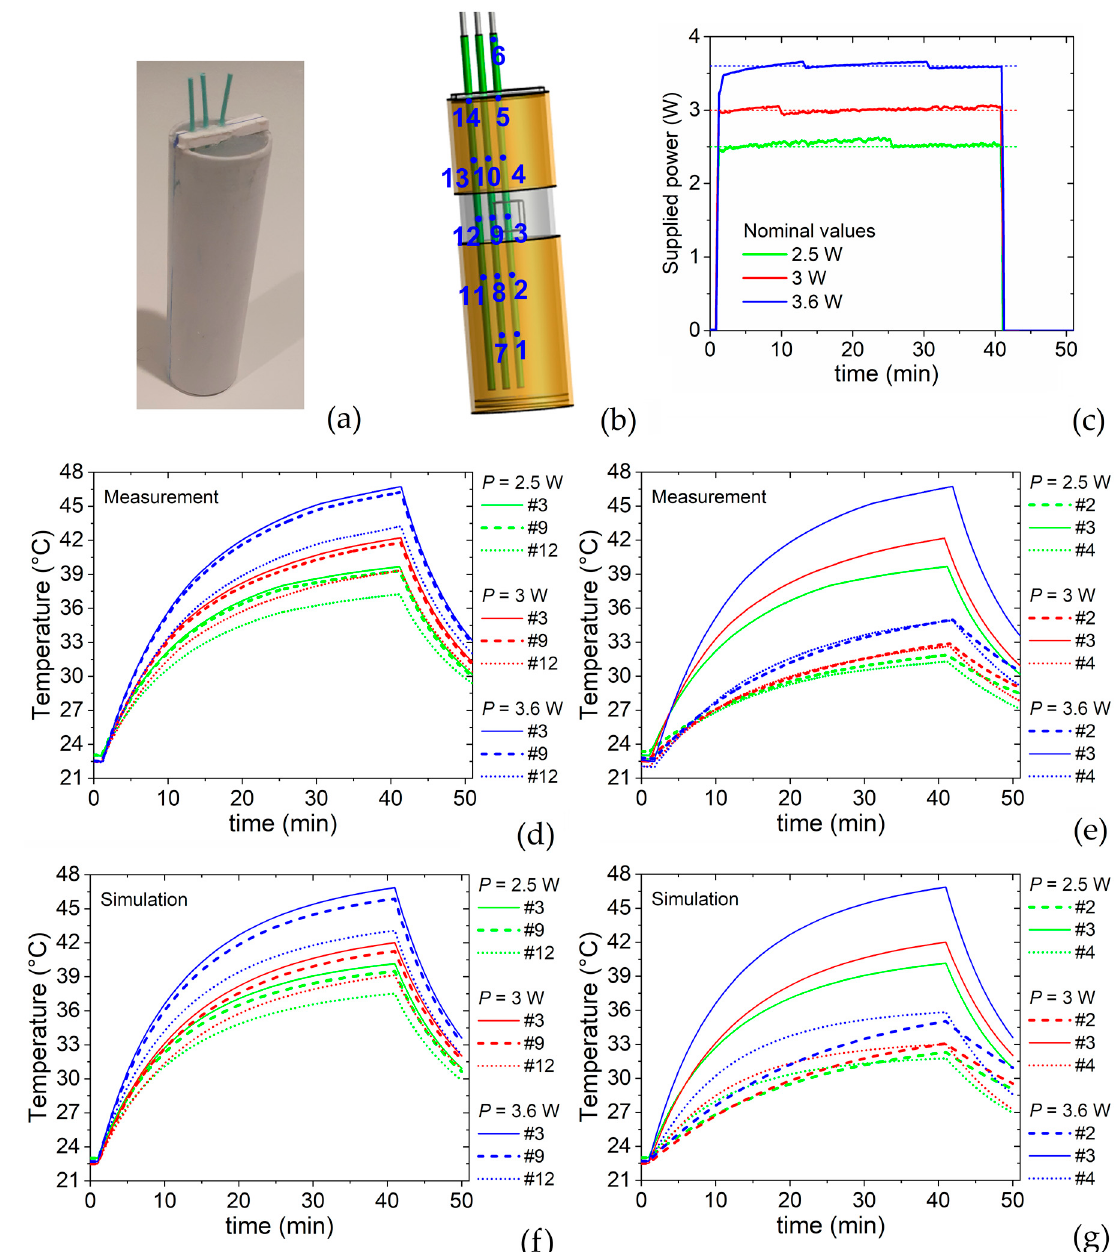
Figure 5. ( a ) Picture of the phantom with the three fiber-optic thermometers arranged along the radial direction. ( b ) Schematics of the phantom, showing the position of the VOI and of the 14 measurement points distributed along the fiber-optic thermometers. ( c ) Time evolution of the effectively supplied power for three power nominal values (2.5 W, 3 W and 3.6 W, as indicated by dashed lines). Heating- cooling transients as a function of supplied power levels: measured time-evolution in points ( d ) #3, #9 and #12, and ( e ) #2, #3 and #4; simulated time-evolution in points ( f ) #3, #9 and #12, and ( g ) #2, #3 and